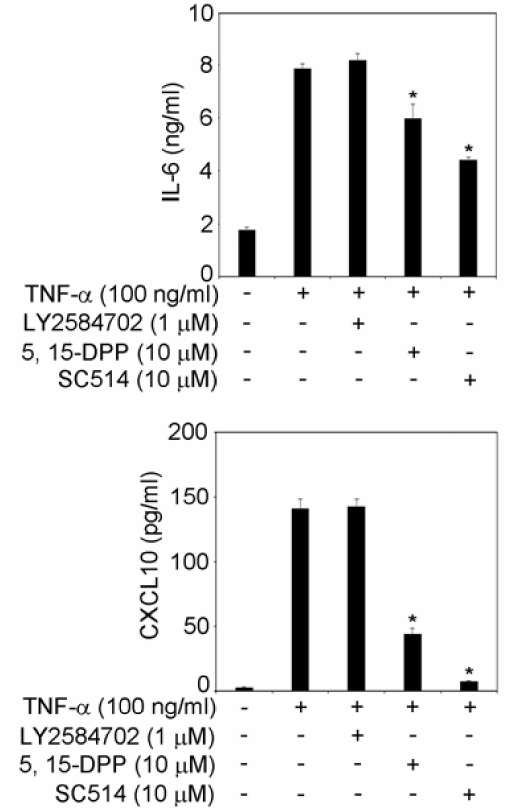
Figure 6. Effects of signal transduction inhibitors on TNF- α -induced production of CXCL10 and IL-6. Sub-confluent TR146 cells were cultured with TNF- α (100 ng/mL) with or without LY2584702 (I µ M), 5, 15-DPP (10 µ M), or SC514 (10 µ M) for 24 h. The amounts of CXCL10 and IL-6 in the supernatant were determined using their respective ELISA kits as described in the Materials and Methods section. Data are expressed as the mean ± SD of 3 independent experiments. * = p < 0.05, significantly different from the TR146 cells stimulated with TNF- α without signal transduction